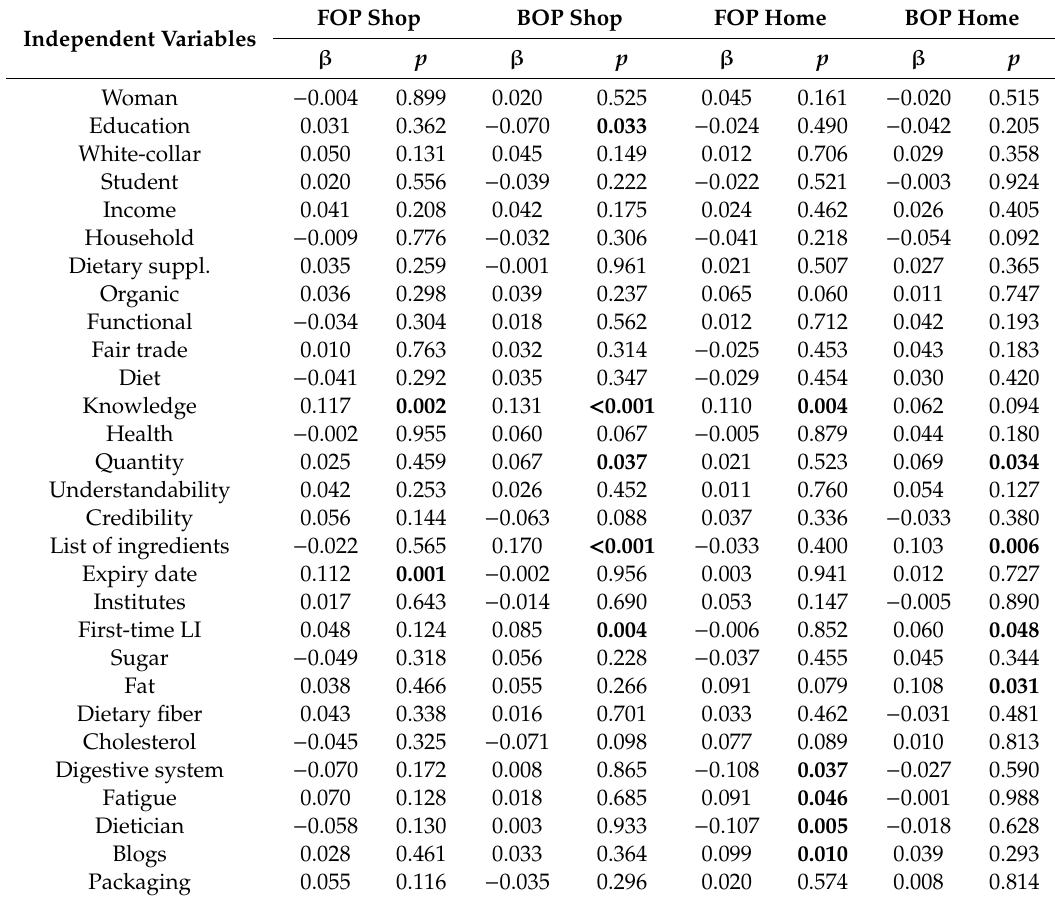
Table 19. Selected predictors of reading food labels—full multiple regression